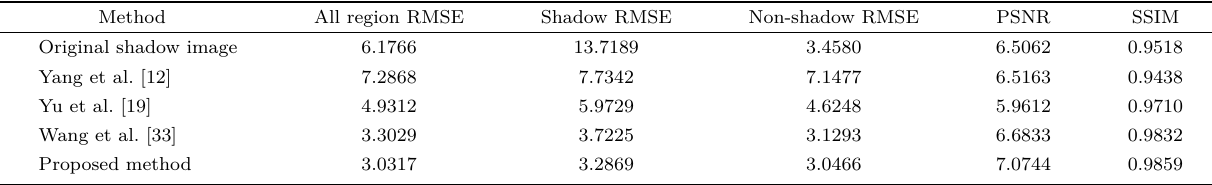
Table 2 Quantitative results for 450 images from the ISTD dataset [33]. The values are averages computed over the set of